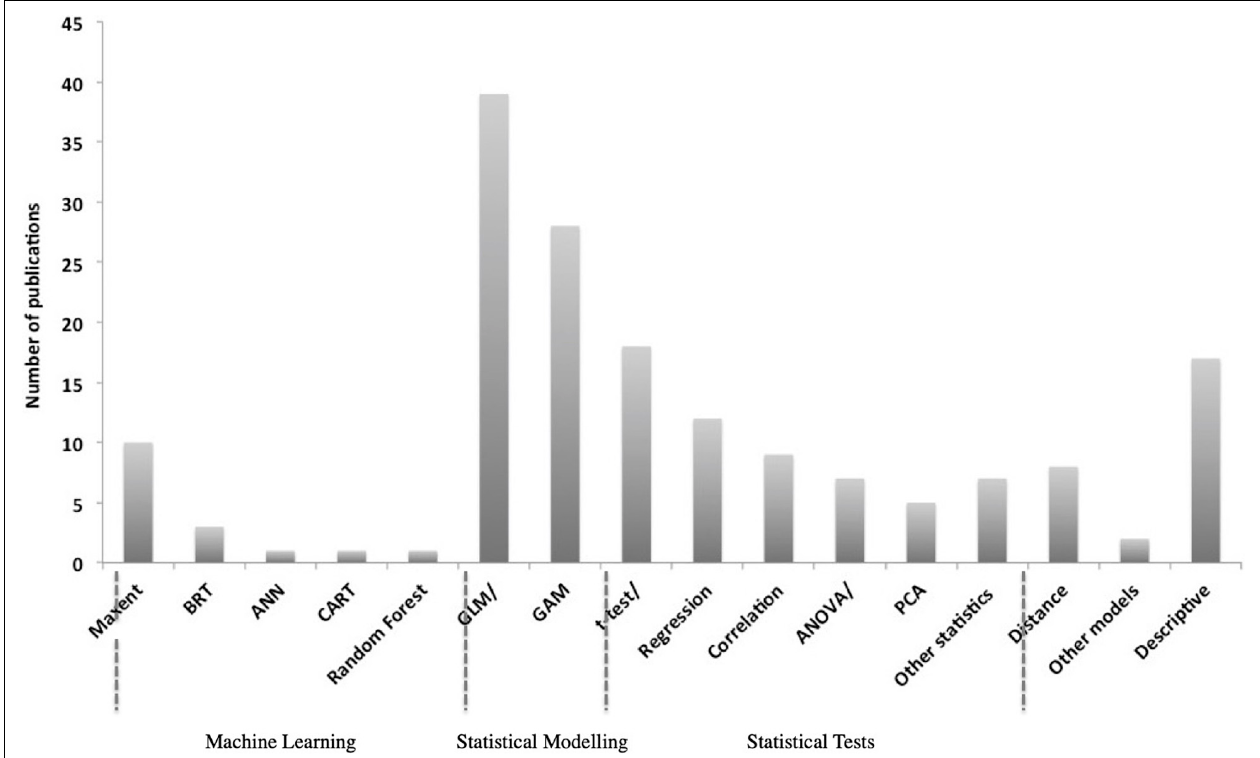
FIGURE 4 | Tendency in the use of methods in order of complexity applied to study humpback whale relationships with environmental drivers extracted from 148 publications. Only the most frequent used methods are presented here based on retrieved studies between 1981–2020 and divided into machine learning techniques, statistical models and tests, and a category that includes usage of Distance software, other seldomly applied models (e.g., occupancy model or relative environmental suitability models) and descriptive assessments.